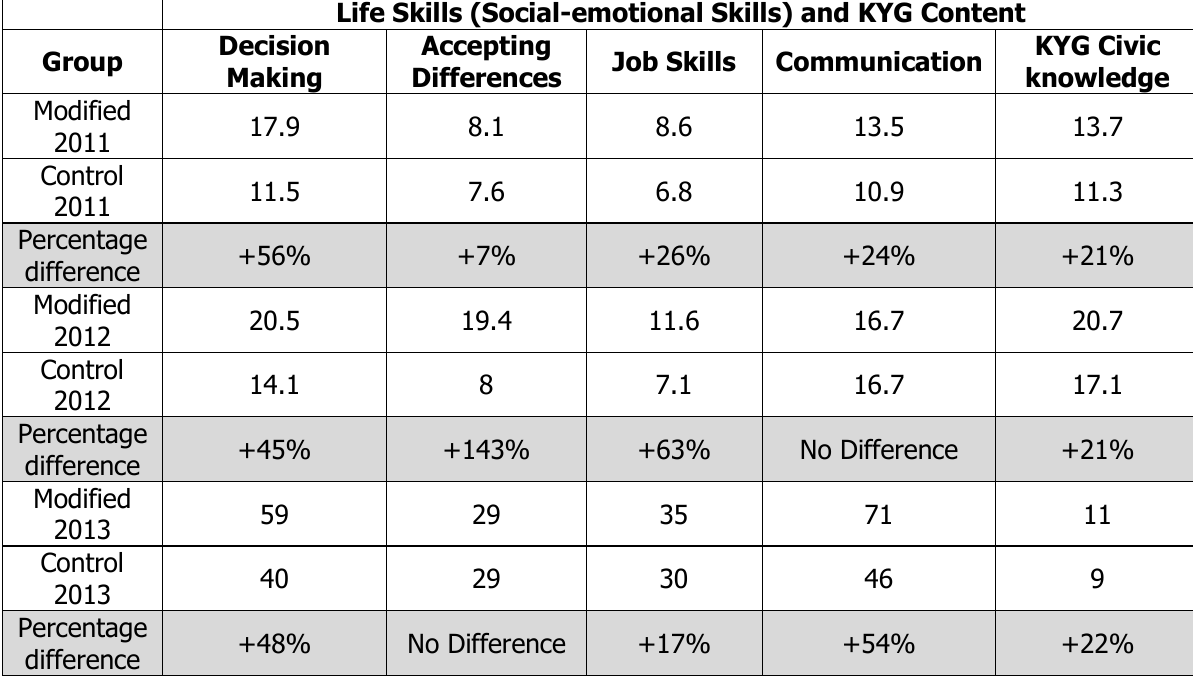
Average percentage differences between modified curriculum and original curriculum (control) Life Skills (Social-emotional Skills) and KYG